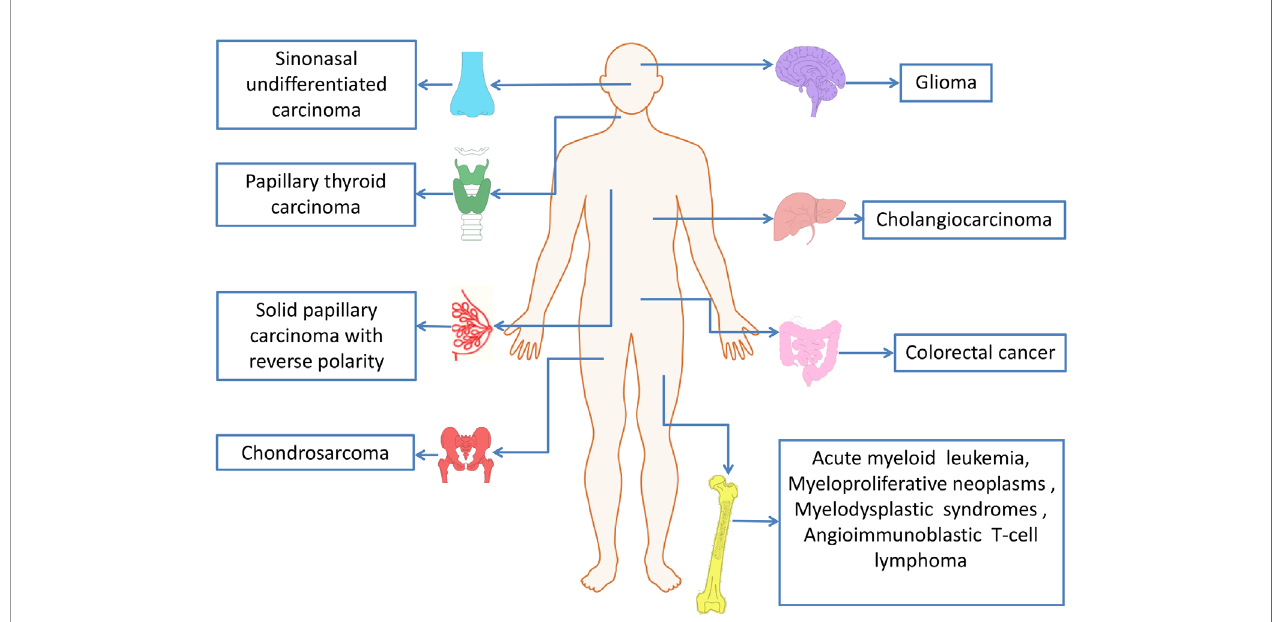
FIGURE 3 | IDH2 mutations in human